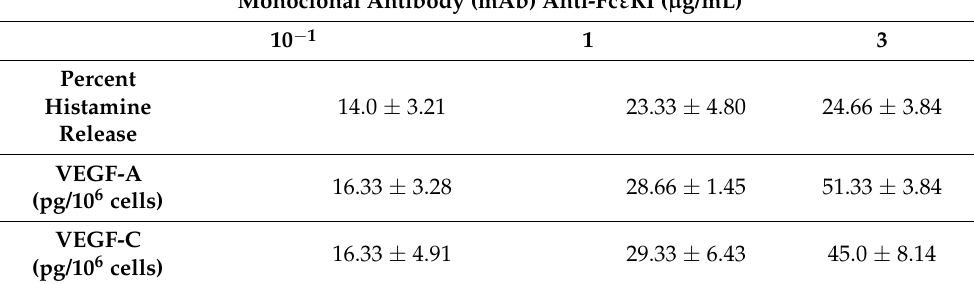
VEGF-C release (12 h at 37 °C). Each value is the mean ± SEM.